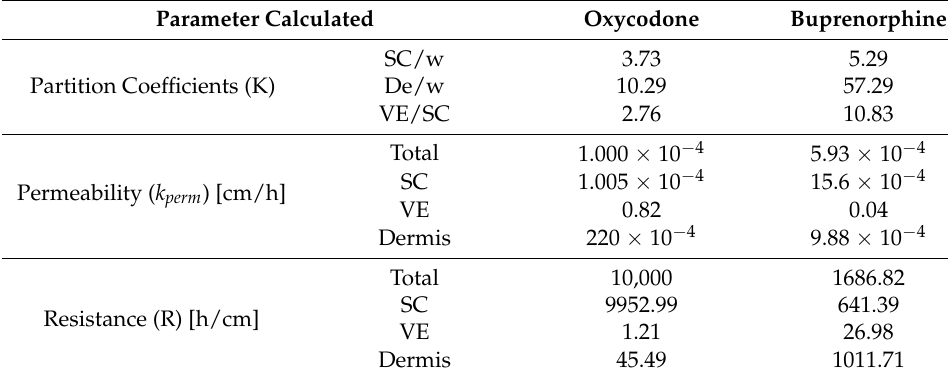
Table 4. Calculated parameters for skin disposition model.